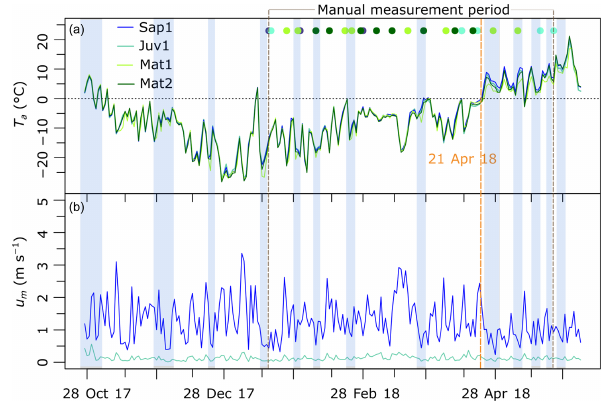
Figure 3. (a) Daily 2m air temperature ( T a ) observations for all the study sites. (b) Daily 2m wind speed ( u m ) for sites Sap1 (sapling) and Juv1 (juvenile). Shaded areas denote periods of low wind speeds ( < 0 . 8ms − 1 ). Coloured points illustrate site-specific snowpit surveys. Spring melt started on 21 April